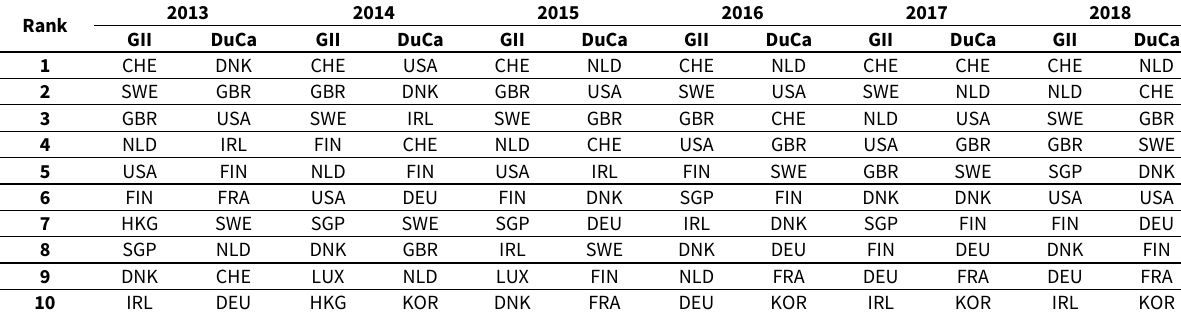
Table 1. Top 10 ranking on the GII against the DuCa framework